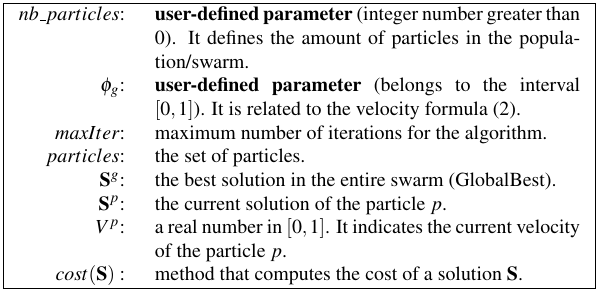
Table 3. Parameters and variables related to the PSO-ANSP al-